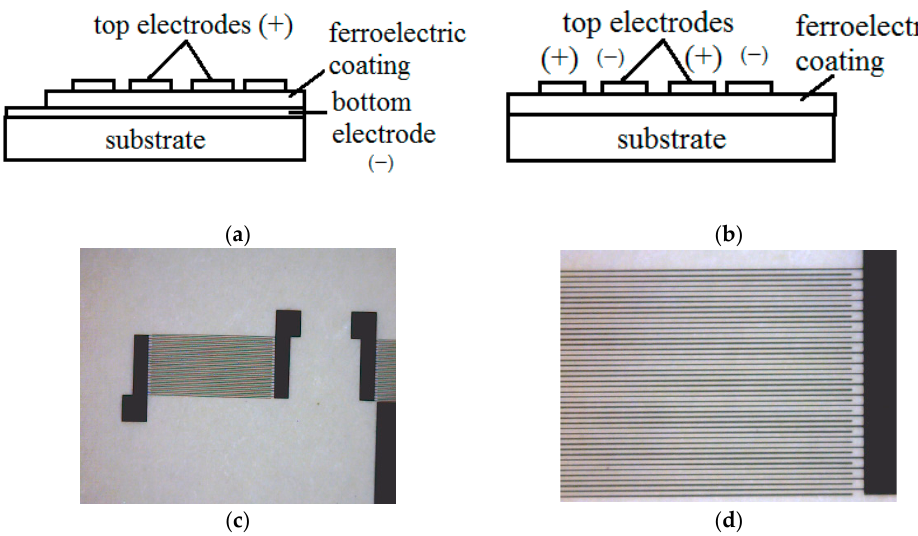
Figure 1. Schematic representation of the sensor configurations: ( a ) parallel electrodes; ( b ) interdigital electrodes and microscopic views of the interdigitated electrodes: ( c , d ) closer view of the interdigital electrode pairs.